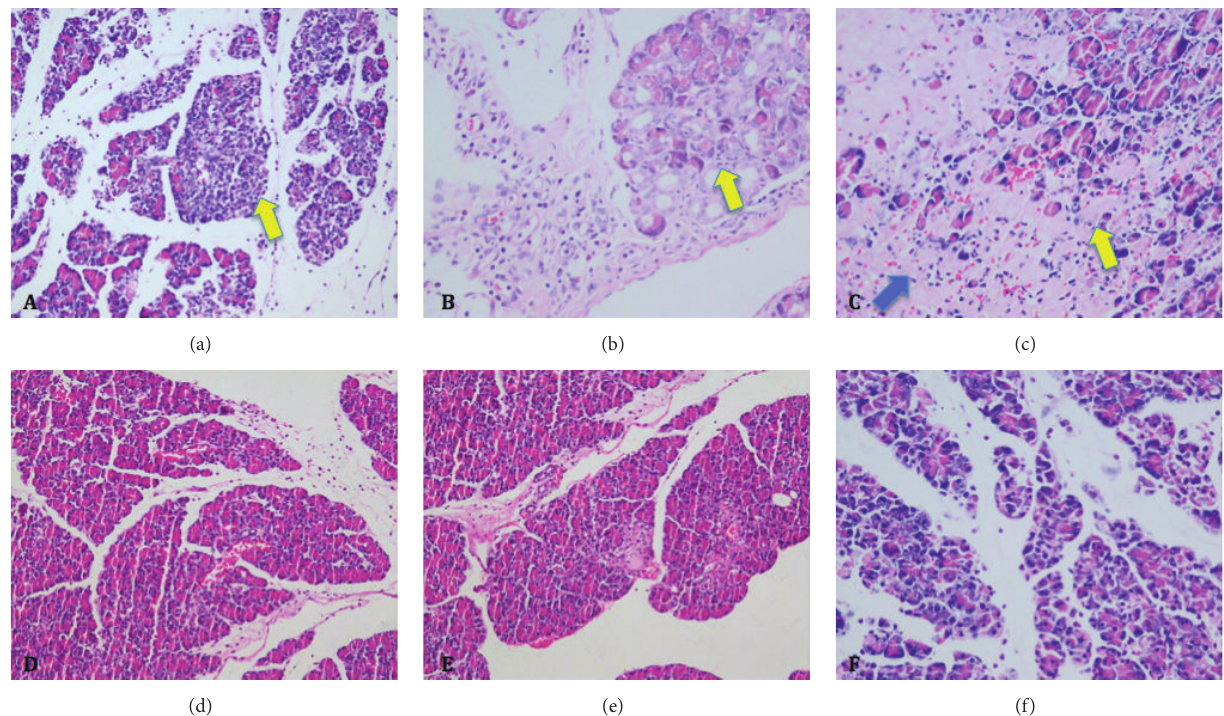
Figure 3: (a–c) Histological findings of pancreatic tissues 72 hrs after PBS infusion (H&E; (a) × 200; (b, c) × 400); (d-e) Histological findings of pancreatic tissues 72 hrs after MSCs transplantation (H&E; (d) × 200; (e, f) × 400). The yellow arrows showed that in the control group the necrosis and inflammation cells infiltration in pancreas were significantly higher than that in MSCs transplantation group. The blue arrow showed that serious hemorrhage could be found in the control